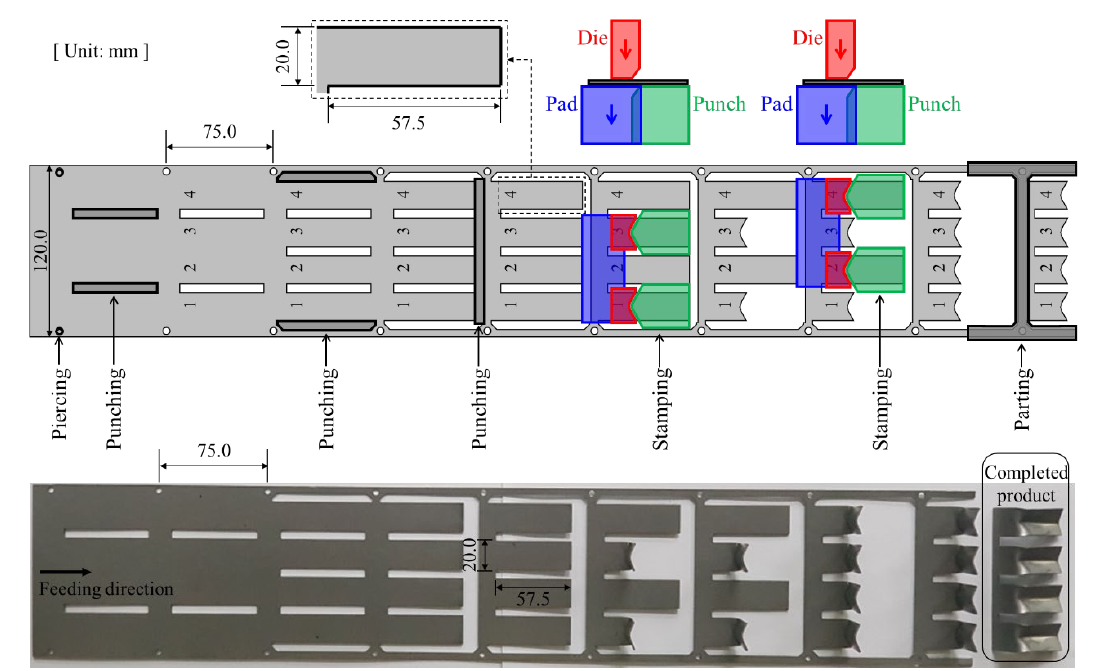
Figure 2. Punch geometry used for the wear test, which is designed to localize wear to the punch radius, as proposed by Bang et al. [35].